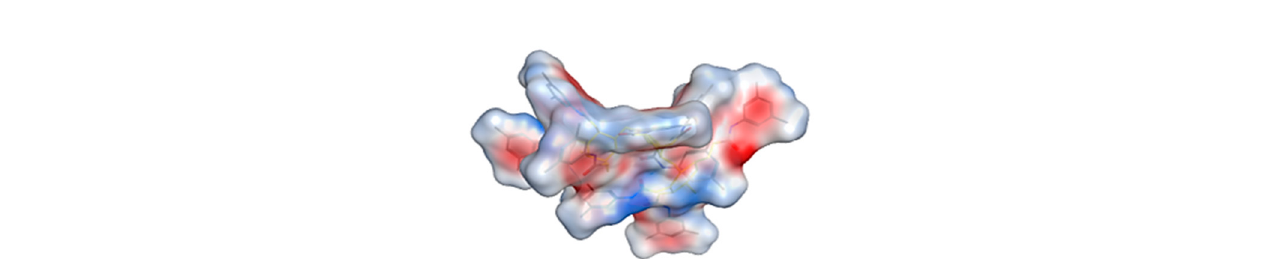
Figure 12. Molecular structure and 3D structures of tris (3,5-dimethylphenylcarbamate)-derivatized cellulose, which was used as chiral selector and, hence, as binding partner for the analyte-CSP docking experiments. Upper part: Left: 2D image of a terminal 3-glucose-unit segment of derivatized cellulose (consisting of β (1 → 4) linked D -glucose units), where the terminal unit has 4 carbamate residues. The derivatized cellobiose subunit is repeated forming the derivatized cellulose polysaccharide. The cellulose core of the molecule (3-unit segment) is marked yellow. Middle: A middle 3-glucose-unit segment as 3D stick image. Cellulose units are marked yellow. Right: 3D stick image similar to that in the middle, yet with yellow transparent surface and-Lower part-with colored surface (TPSA), where red represents more negative and blue positive areas.